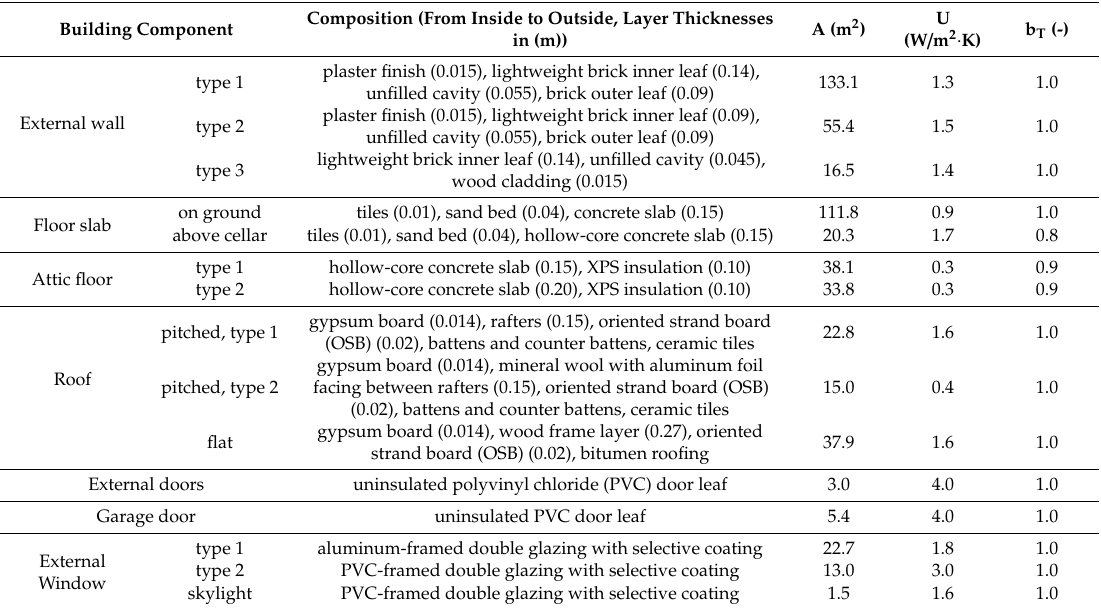
Table 1. Composition, surface area (A), U-value, and temperature ratio (b T ) of the building components the building fabric of interest is composed